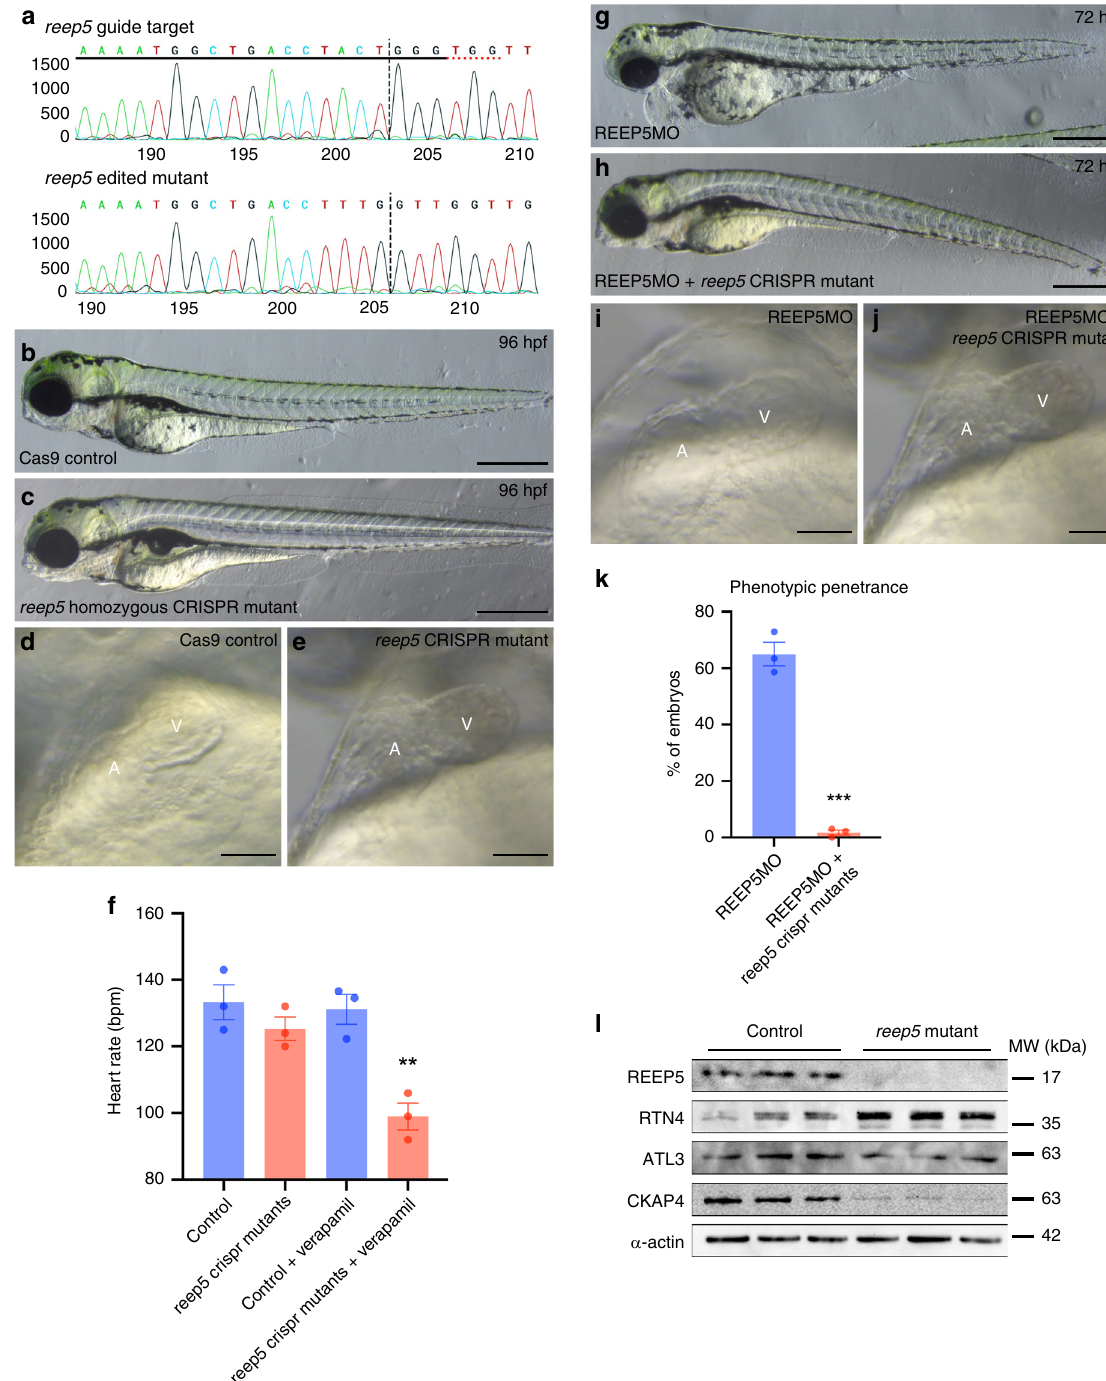
(FBS)/horse serum. Cells were then seeded on gelatin-coated glass-bottom dishes for 48h before being maintained in culture medium (insulin-transferrin-sodium